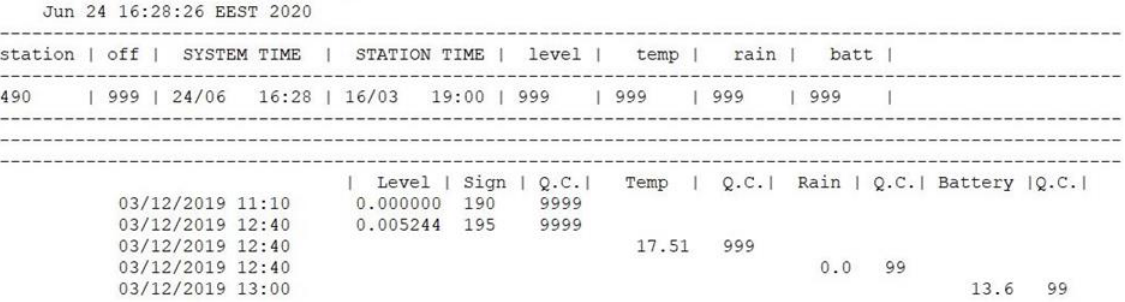
Figure 6. Sample of the output file report.txt of audit code.